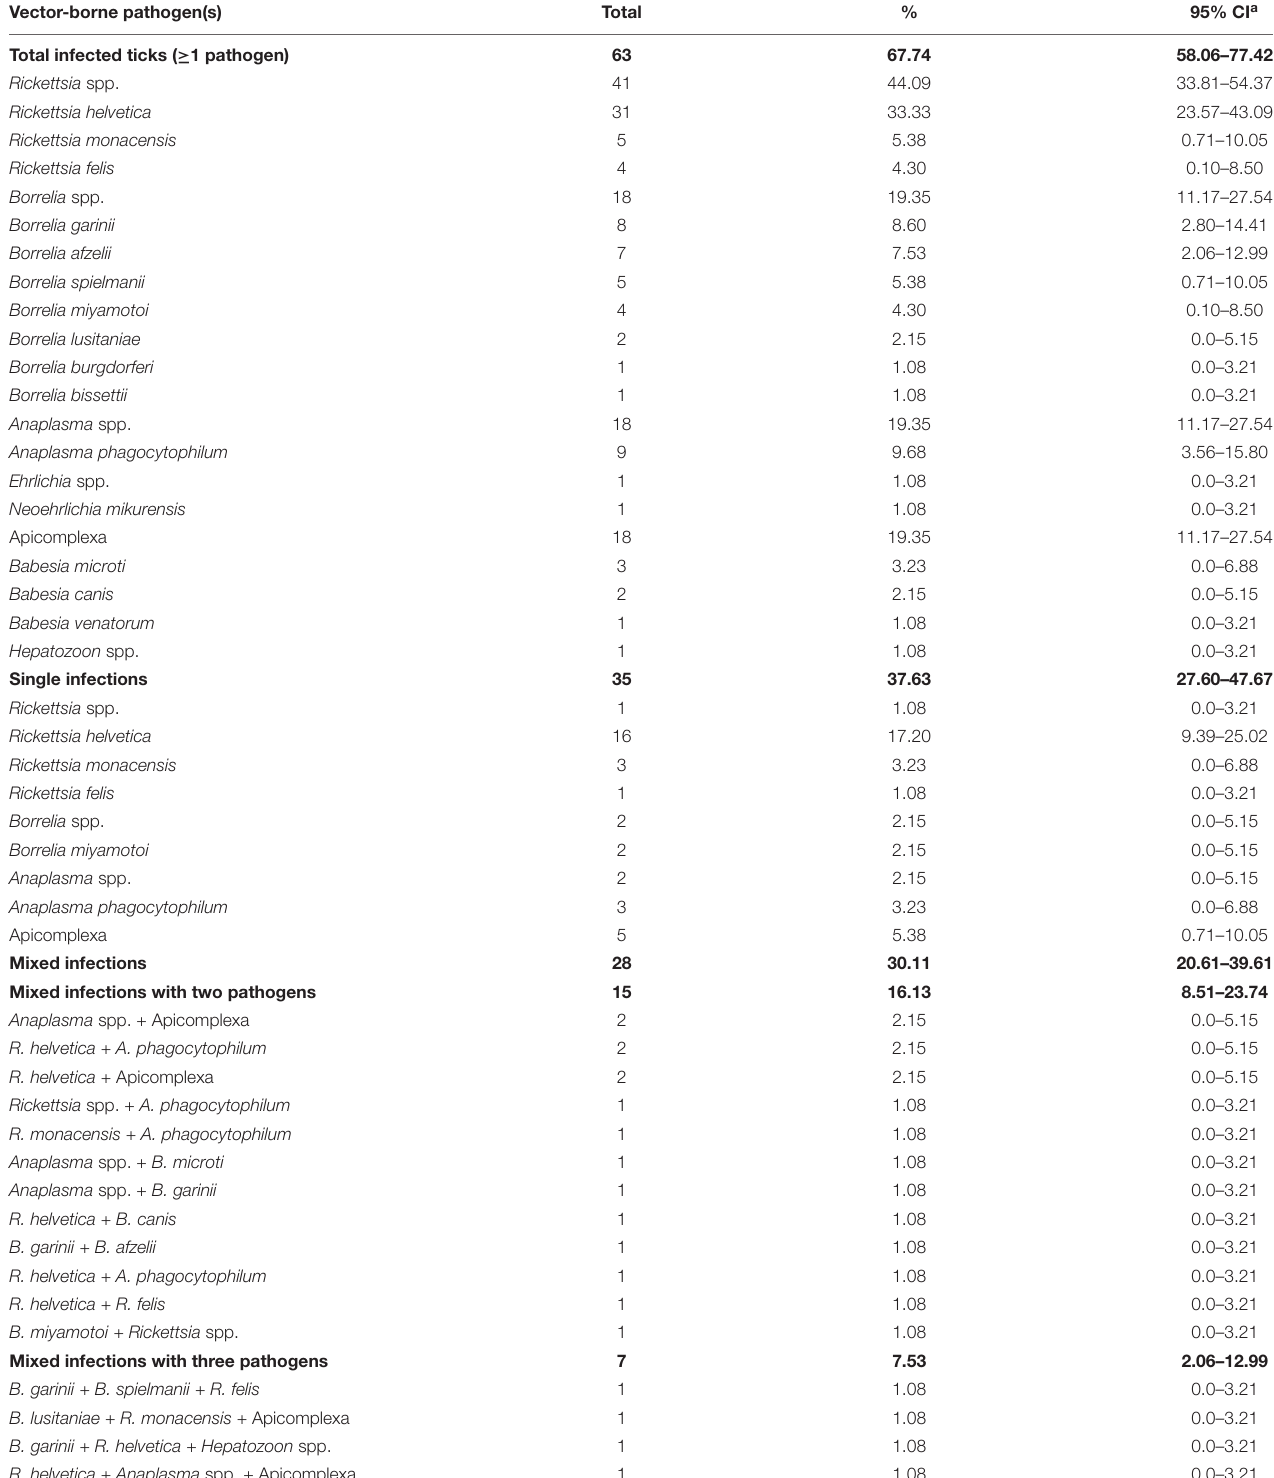
TABLE 3 | Vector-borne pathogens detected in ticks from Serbia using microfluidic PCR. Vector-borne pathogen(s) Total % 95% CI a Total infected ticks ( ≥ 1